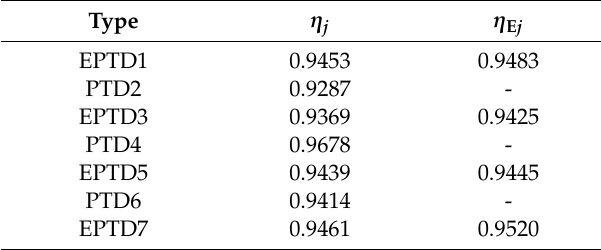
Figure 21. The diagram of the modified railway system. Table 1. Converter efficiency